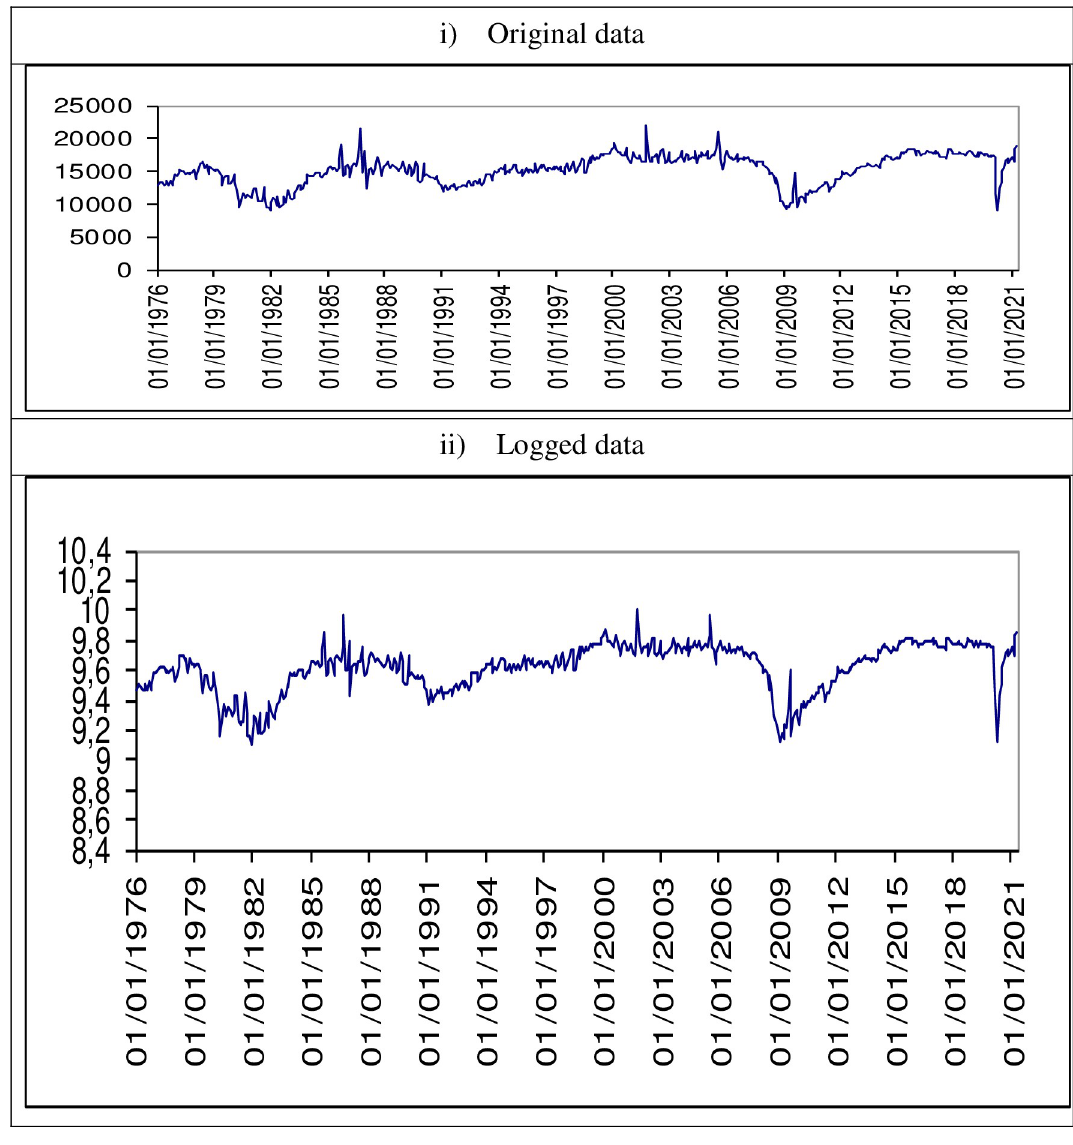
Fig 2. Time series